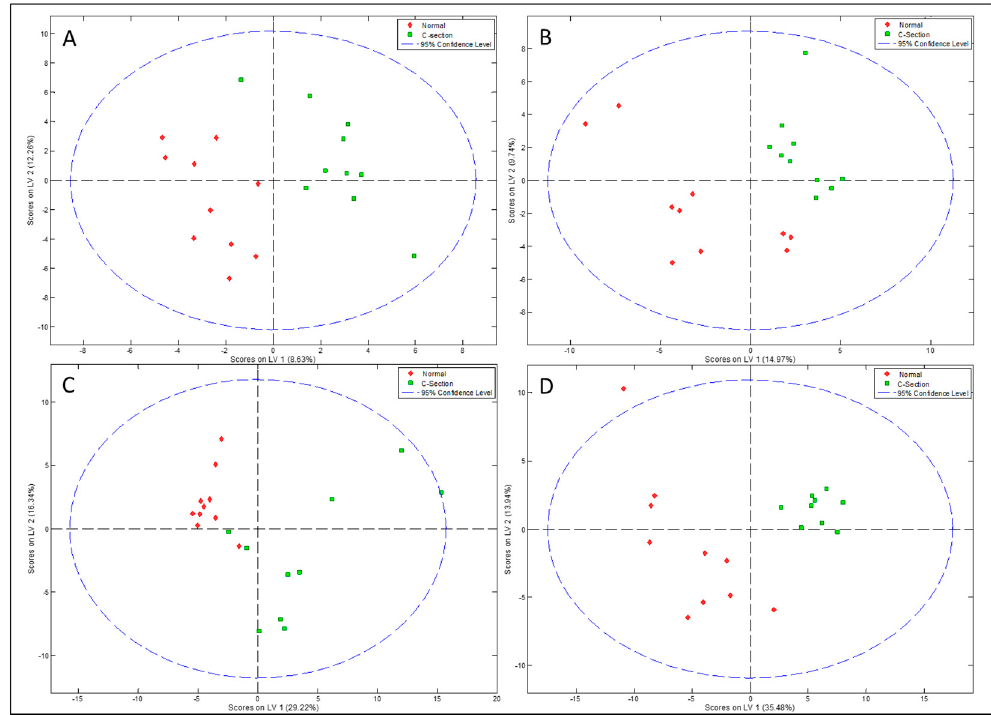
Figure 7. Partial least squares discriminant analysis scores plot scaling nuclear magnetic resonance (NMR) data from vaginal delivery samples (red) and caesarean section (green) from China ( A ), Finland ( B ), Spain ( C ), South Africa ( D ). Table 2. Significant differences by country ( p -value) in specific metabolites in human milk after vaginal or caesarean delivery.